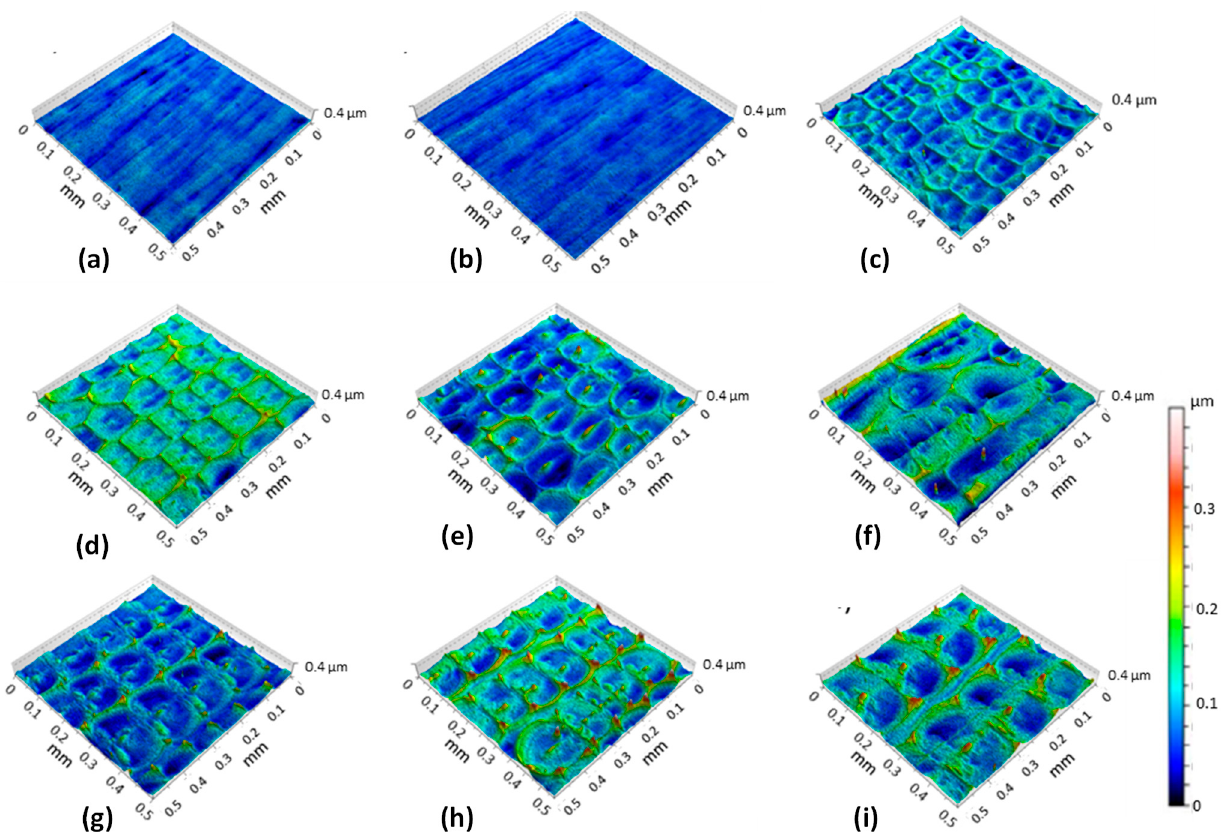
Figure 9. 3D topography images of the area 500 µ m × 500 µ m for coatings obtained with different withdrawal rates ( a ) 1.2 mm/s, ( b ) 2.3 mm/s, ( c ) 4.5 mm/s, ( d ) 7.0 mm/s, ( e ) 9.3 mm/s, ( f ) 11.7 mm/s, ( g ) 17.4 mm/s, ( h ) 23.3 mm/s and ( i ) 48.3 mm/s. Coatings were deposited on structural steel and cured at 180 °C.